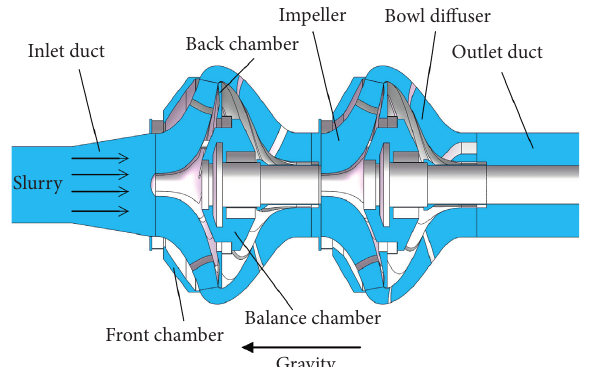
Figure 2: Computational domain of the pump.